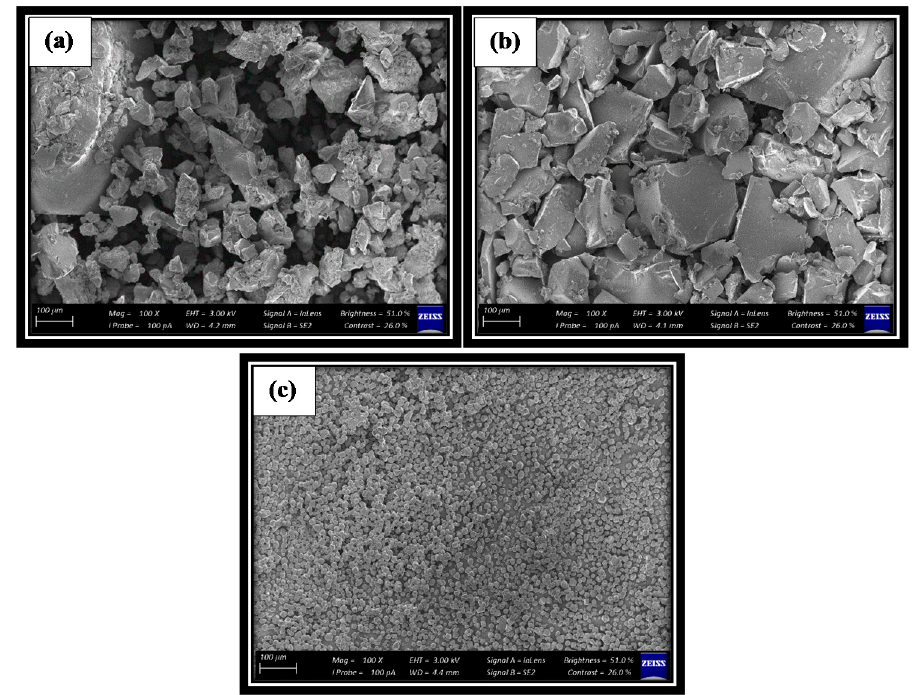
Figure 3. Scanning electron microscopy (SEM) microphotographs of freeze-dried